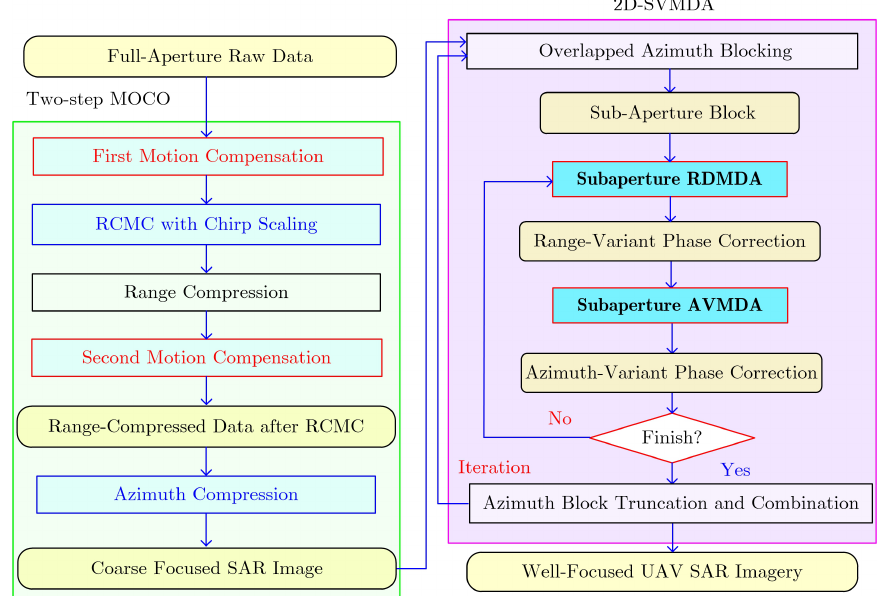
Figure 5. The block diagram of the Unmanned Aerial Vehicle (UAV) SAR imaging with Two-Dimensional Spatial-Variant Map-Drift Algorithm (2D-SVMDA). RCMC = Range Cell Migration Correction, RDMDA = Range-Dependent Map-Drift